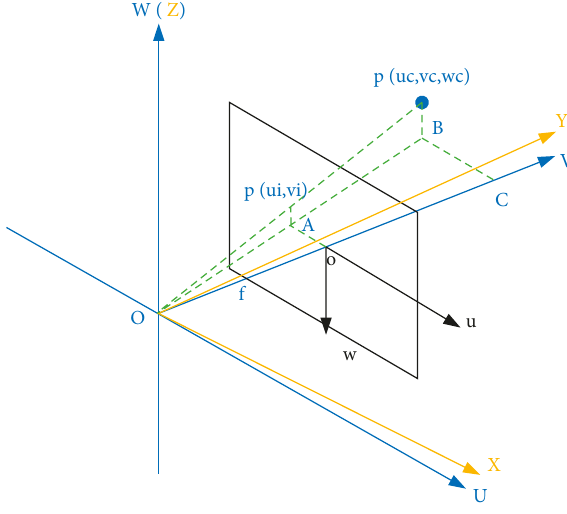
Figure 7: Radar-camera coordinate.